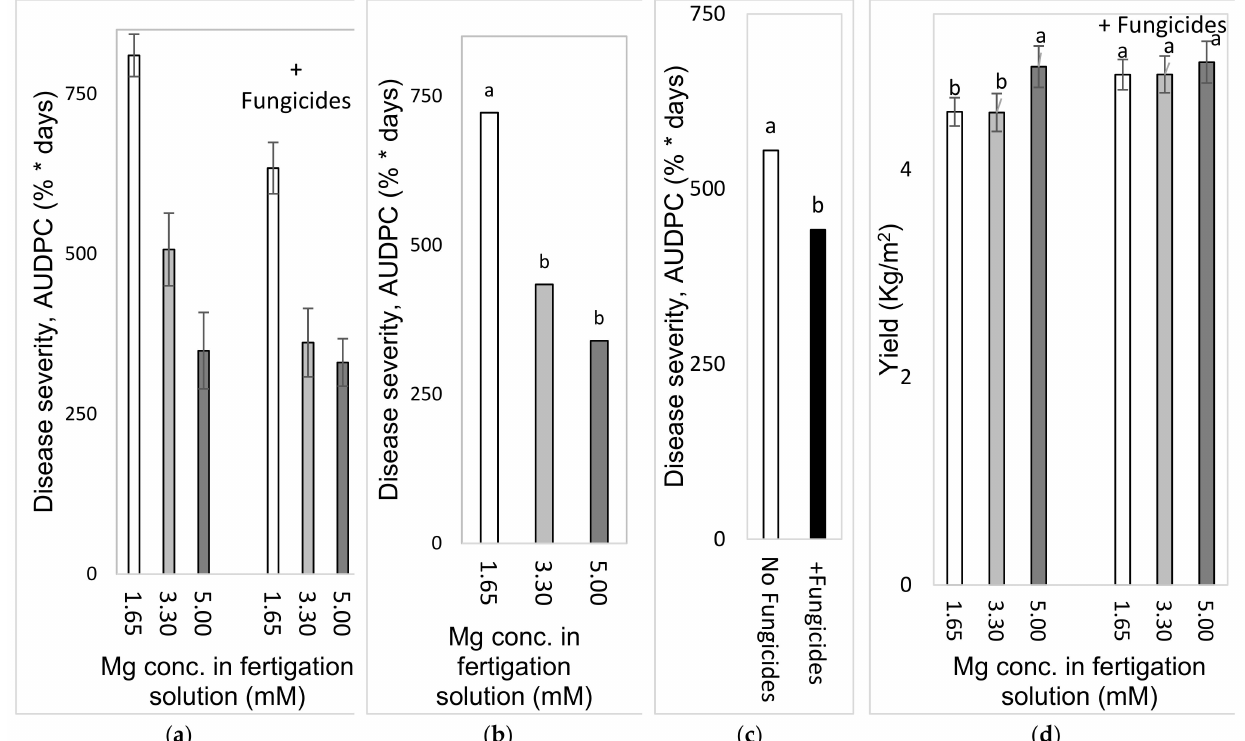
Figure 10. Effects of different Mg concentrations on ( a – c ) the severity of sweet basil downy mildew (SBDM) and ( d ) cumulative shoot weight at 110 days after planting. Plots were not treated or treated with chemical fungicides ( a , c , d ). SBDM severity was evaluated on a 0–100% scale, in which 0 = healthy plants and 100% = plants completely covered by SBDM symptoms/signs. The area under disease progress curve (AUDPC) over 63 days was calculated. The interactive effect of Mg treatments and fungicide treatments on SBDM severity was not significant ( a ). Each Mg concentration ( b ) and fungicide treatment ( c ) followed by a different letter is significantly different from the others, according to two-way ANOVA with Tukey’s HSD test. The interaction between the Mg treatments and the fungicide treatment significantly affected yield, so an analysis of shoot weight is presented for the individual treatments. Yield values corresponding to the three Mg treatments in both fungicide treatments that are followed by a different letter are significantly different from each other ( d ) according to two-way ANOVA with Tukey’s HSD. Default significance levels were set at α = 0.05. Bar =